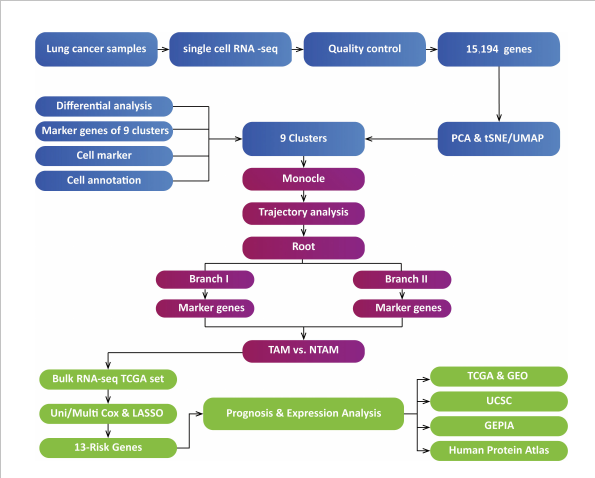
FIGURE 1 Analysis overview. TAMs, tumor-associated macrophages; NTAMs, non-tumor-associated macrophages; TCGA, The Cancer Genome Atlas; PCA, Principal Component Analysis; GEPIA, Gene Expression Pro fi ling Interactive Analysis; LASSO, Least absolute shrinkage and selection operator; t-SNE, t-Stochastic Neighbor Embedding; UMAP, Uniform Manifold Approximation and Projection for Dimension Reduction; USCS, University of California Santa Cruz; GEO, Gene Expression